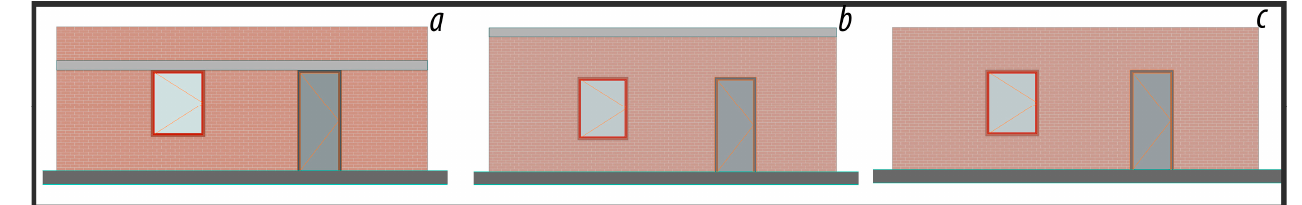
Figure 15. Lack of horizontal bond beam: ( a ) Above the window, ( b ) Above the wall, ( c ) No bond beam.